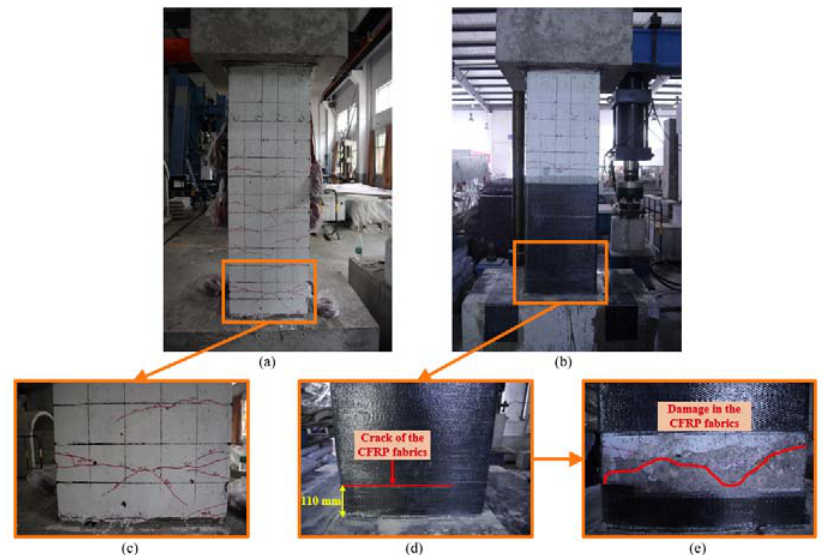
Figure 8. Damage of tested specimens: ( a ) original specimen; ( b ) repaired specimen; ( c ) crack details for the original specimen; ( d , e ) crack details for the repaired specimen.